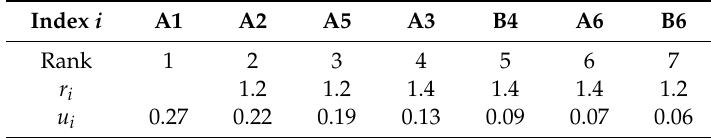
Table 2. The weights obtained by order relations method based on investors (expert 1 as